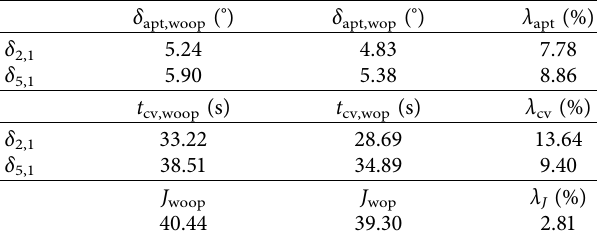
DC,ref and optimization